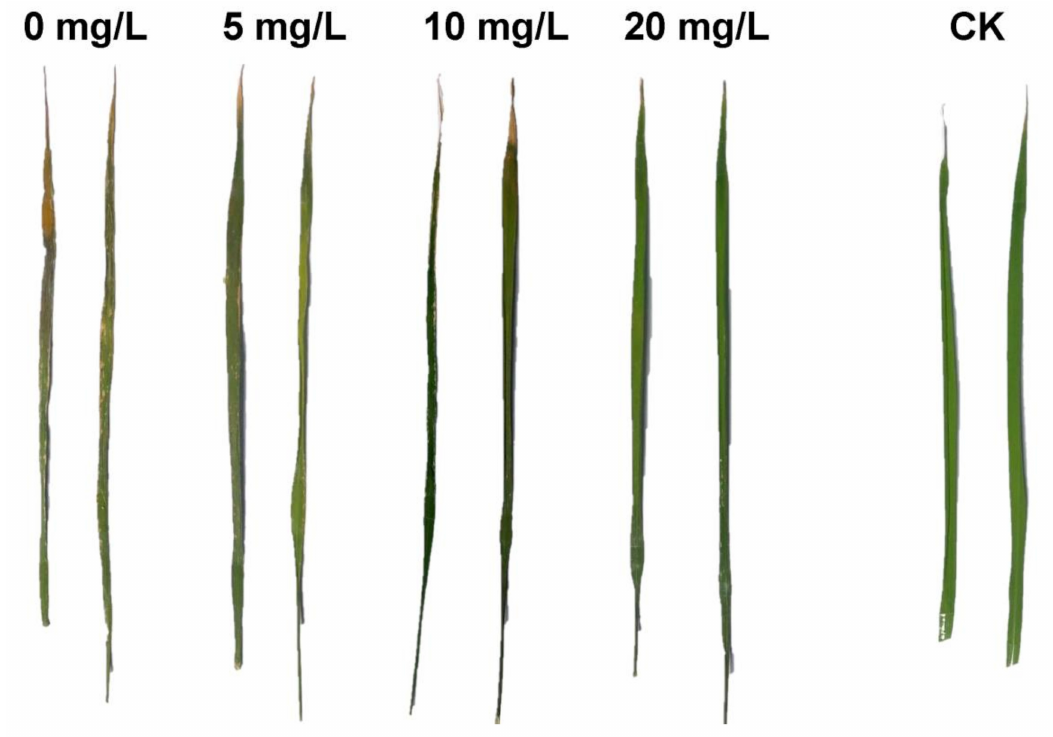
Figure 10. E ff ect of CMC-SNs on cure of rice bacterial